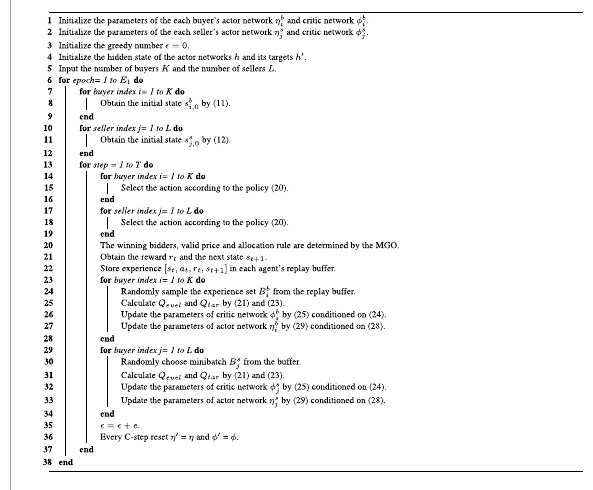
Algorithm1. TrainingprocessfortheDRL-basedenergybiddingstrategy.